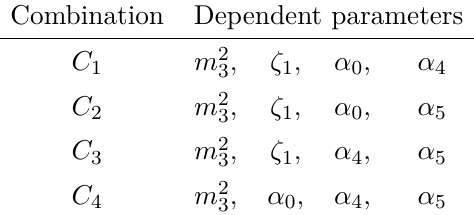
Table 1. Dependent parameters for each combination C i